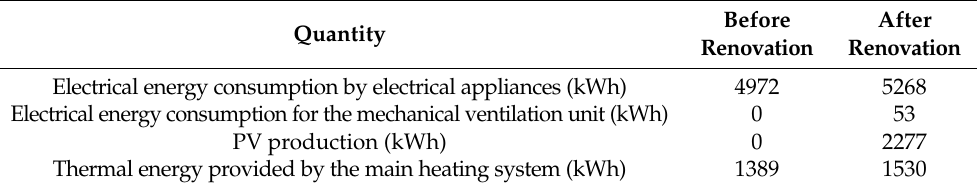
Before Renovation